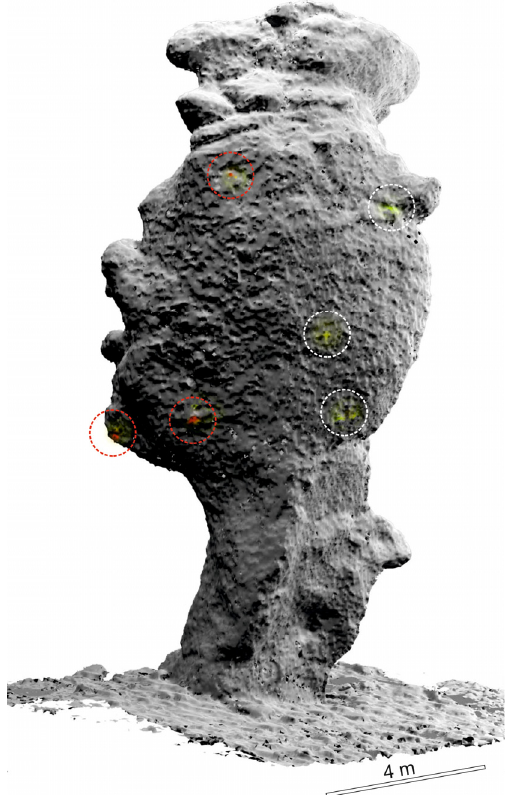
Figure 5. A mesh model of a rauk at Langhammars with marked erosion points. The identified points of clear erosion were marked with red lines, and changes within the method’s accuracy limit were marked with white lines.